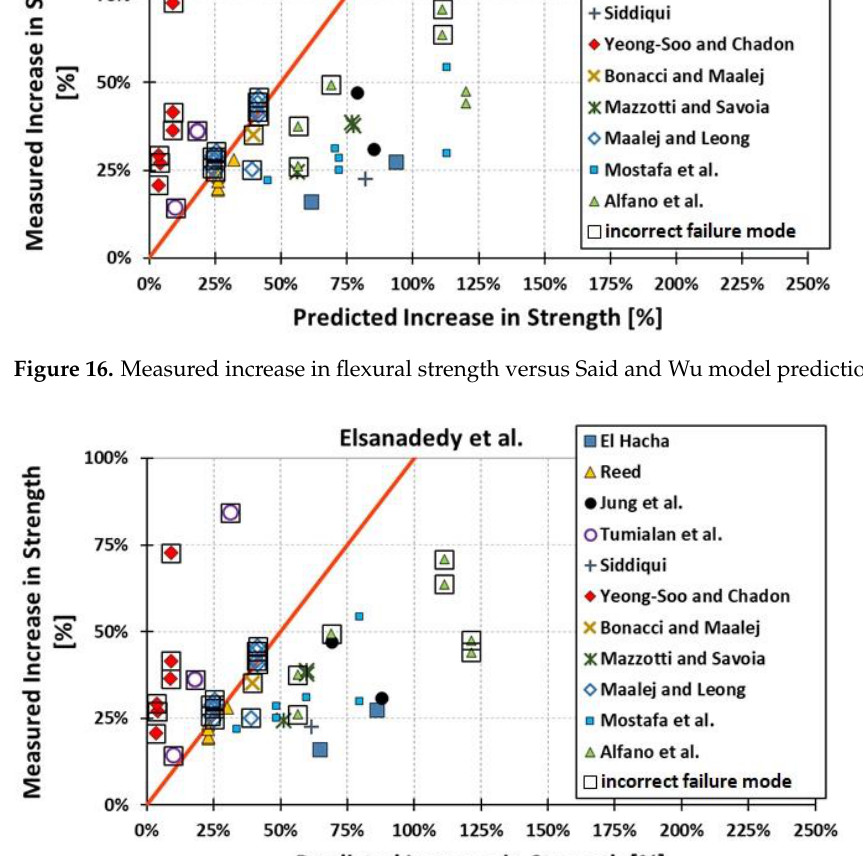
Figure 17. Measured increase in flexural strength versus Elsanadedy et al. model prediction.